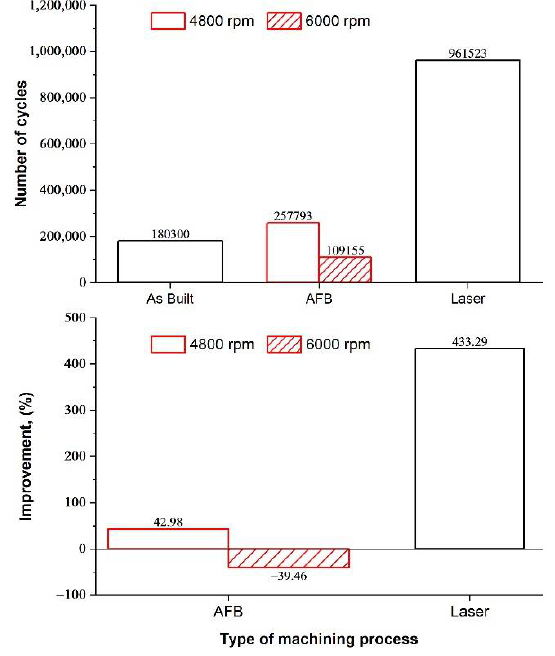
Figure 9. Number of cycles to failure for: as-built samples, samples treated by AFB for 10 h at different speed, laser treated samples with Fd = 5 mm and Ss = 3.6 mm/min.